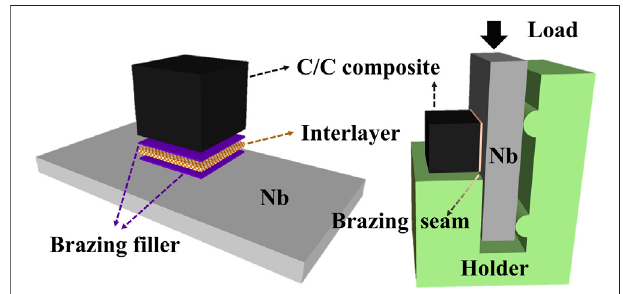
FIGURE1| Schematicofthebrazingassembly (left) and shearstrength test assembly (right)